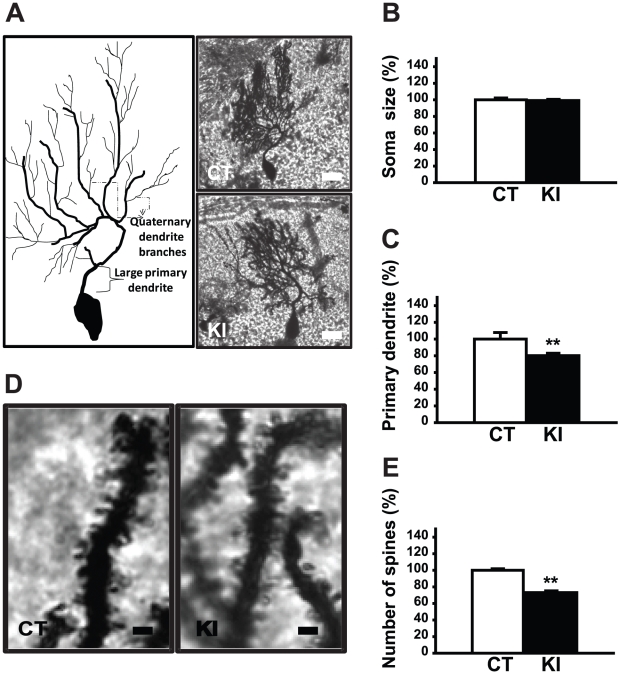
Purkinje cells in KI mice.(A) A representative Purkinje cell trace (left). A representative Purkinje cell from CT and KI mice at 40× magnification (right). (B) There was no significant difference in size of the Purkinje cell soma between CT and KI mice. (C) However, the large primary dendrite of the Purkinje cells in the KI mice was significantly shorter than those in CT mice. (D) Next, the quaternary dendrite branch of CT and KI mice was examined at 100× magnification. (E) The number of spines on the quaternary dendrite branch in the KI mice was significantly reduced compared to CT mice. Scale bars in Panel A represent 10 µm. Scale bars in panel D represent 1 µm. Bars in Panels B, C and E represent means with standard errors. ** p<0.01.